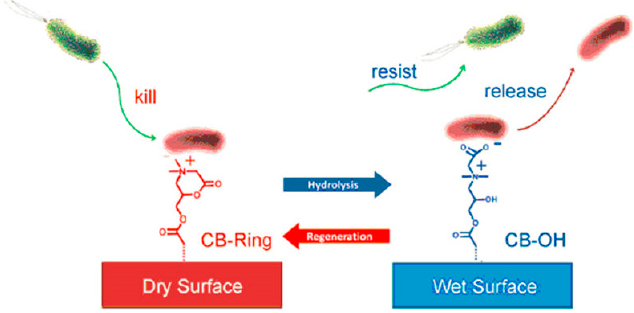
Figure 8. A reversible switch between antibacterial surface of poly(45) enable to kill bacteria in the polycationic state and hydrolysed polyzwitterionic state poly(46) permitting to release dead bacterial cells along with resistance against bacteria cells adhesion. Regeneration to poly(45) is through an acidic dehydration process. Reprinted with permission from Reference [98], Copyright 2012, Wiley-VCH.